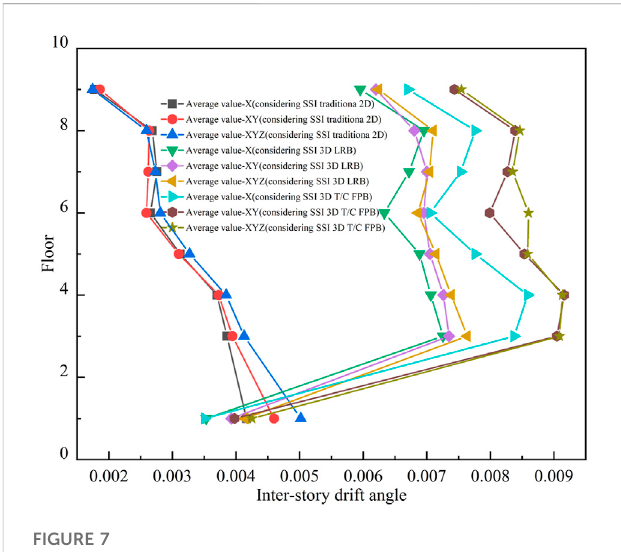
FIGURE 7 Inter-story drift angle of the